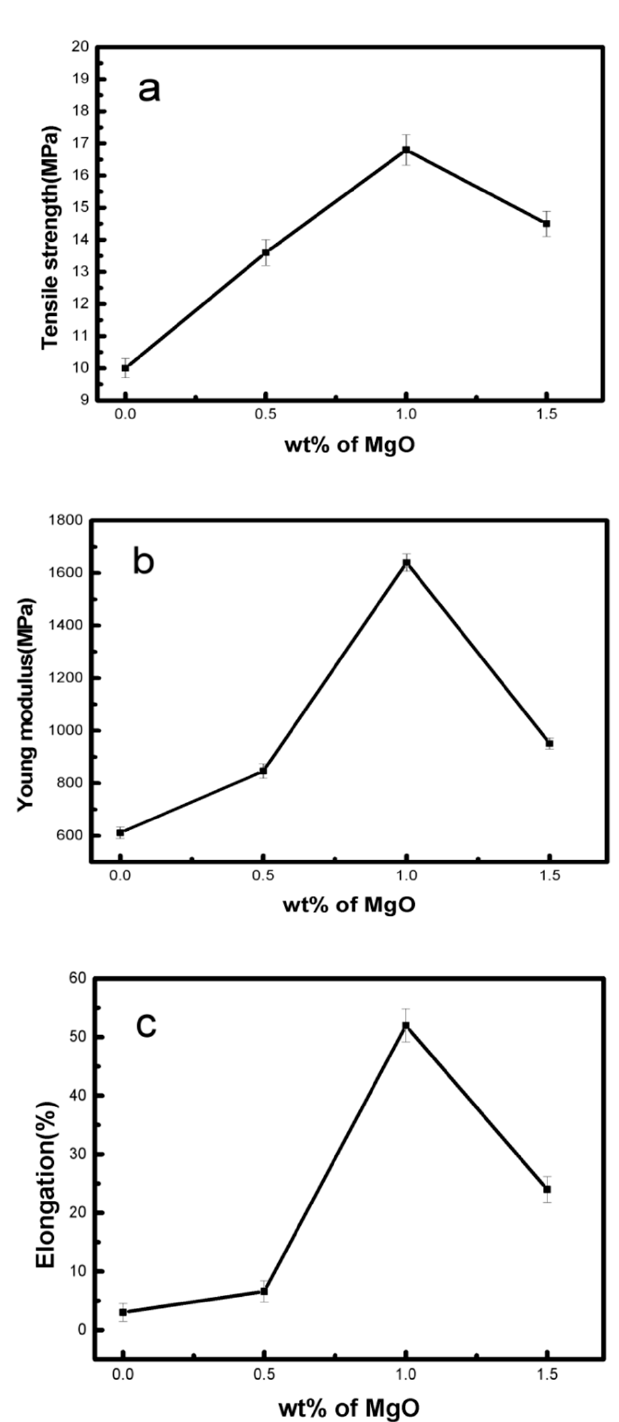
Figure 9. Mechanical properties of PLLA and PLLA–MgO composites.